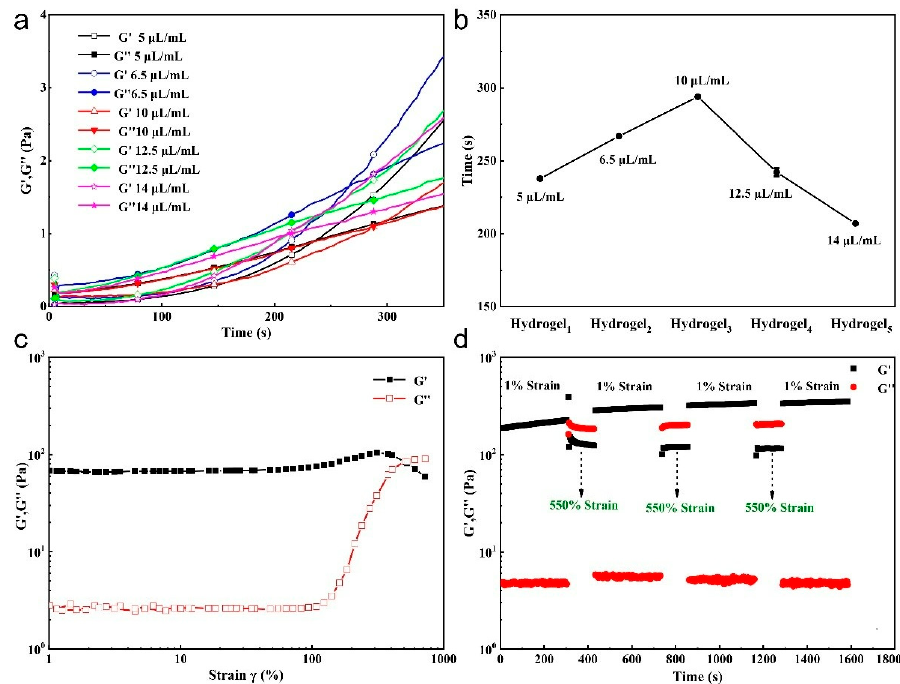
Figure 3. ( a ) Gelation time of SH-CMCS/OSA hydrogel at different but-3-yn-2-one concentrations; ( b ) Gelation time change of SH-CMCS/OSA hydrogel at different but-3-yn-2-one concentrations; ( c ) Maximum strain analysis of hydrogels with but-3-yn-2-one concentration of 5 μ L/mL; ( d ) Rheological analysis of hydrogel at 5 μ L/mL but-3-yn-2-one concentration.